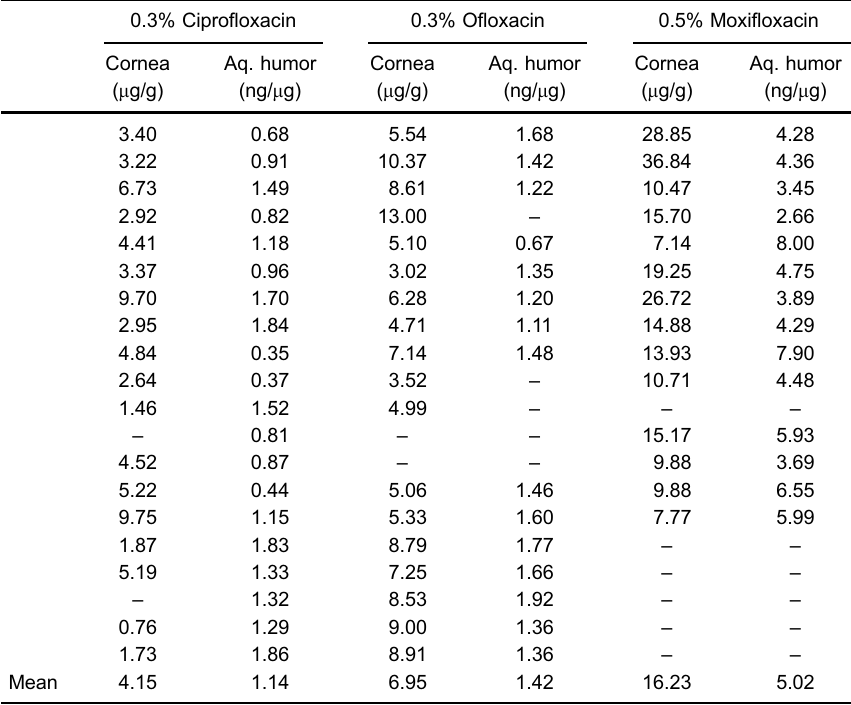
Table 1. Antibiotic concentrations in eyes immersed for ten minutes in three different